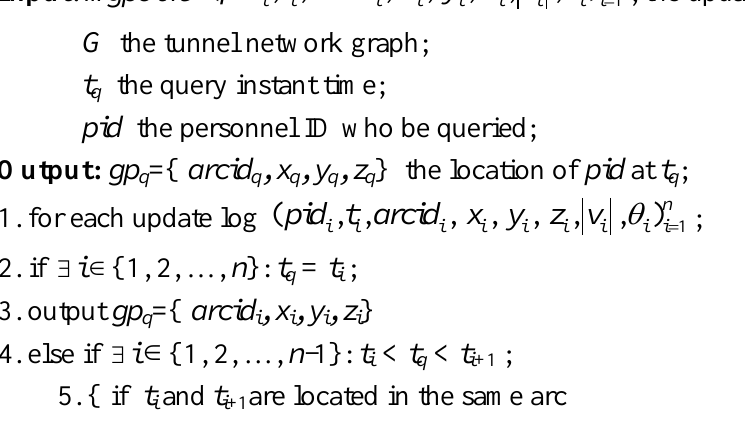
Algorithm 2. PositionEstimation(